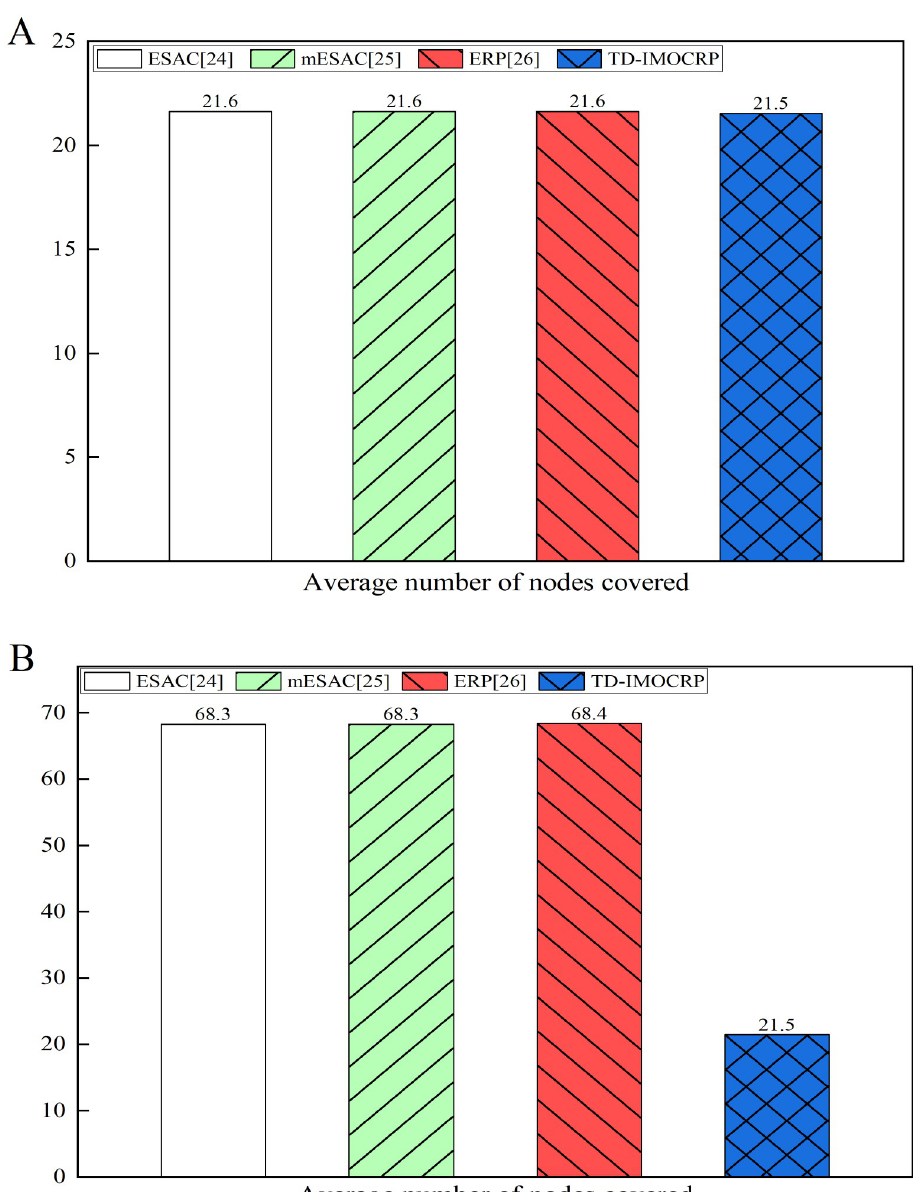
Fig 13. Comparison results of average number of covered nodes. (A) The sink is located at the center. (B) The sink is located at